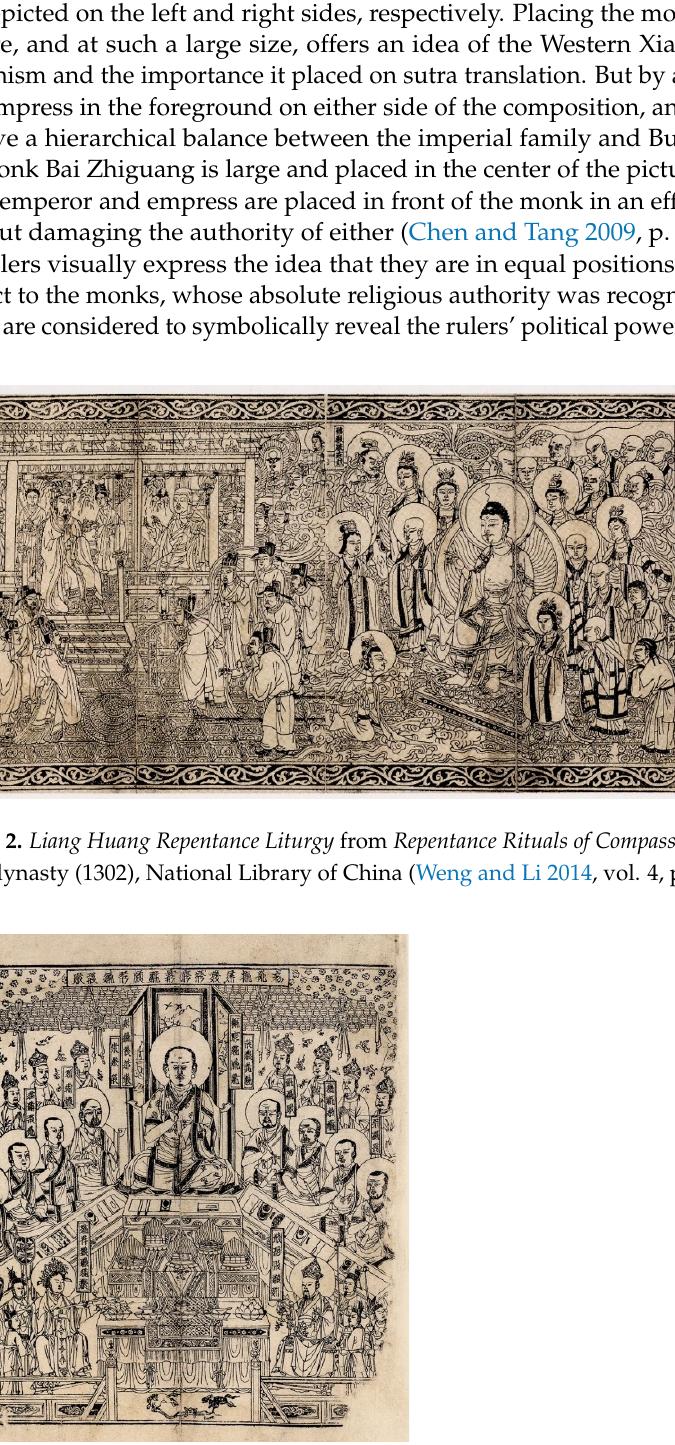
Figure 3. Translating the Sutras in Western Xia from The Thousand Names of the Buddha of the Present, 26.4 × 24.6 cm, Yuan dynasty, National Library of China (Li 2008, vol. 1, Figure 129).